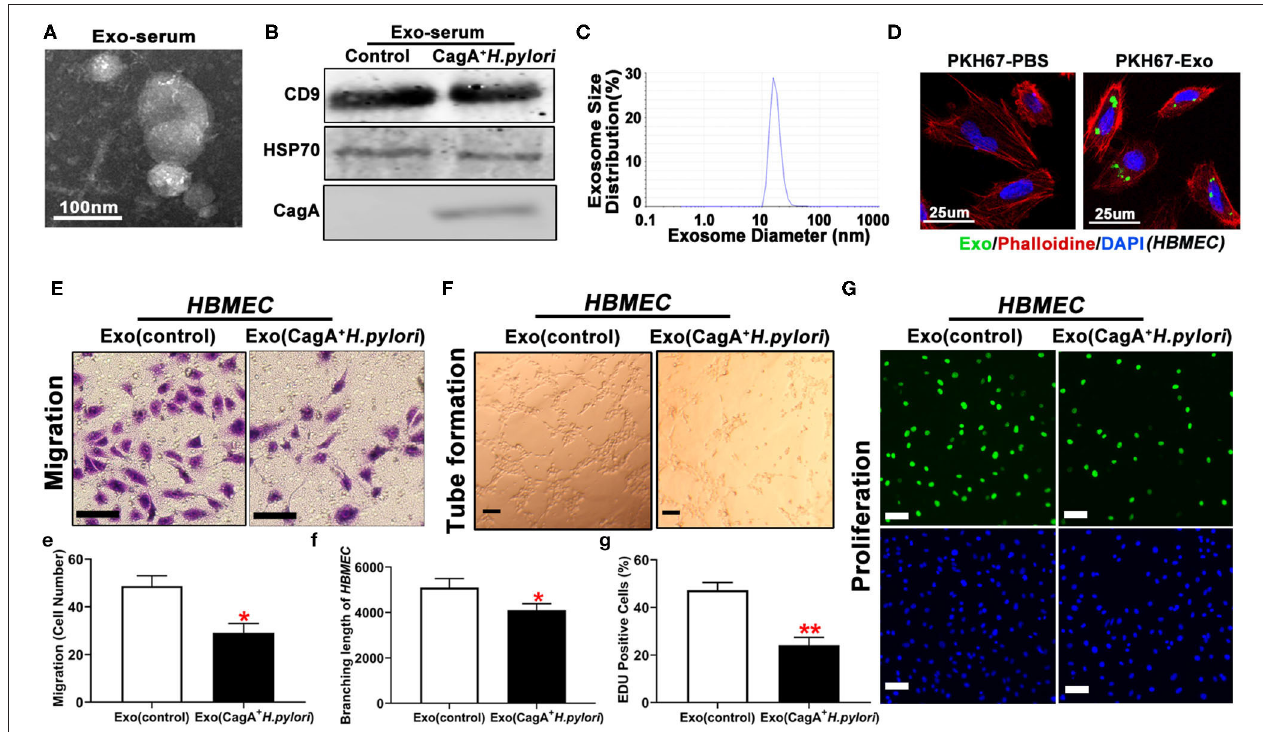
FIGURE 2 | Serum exosomes from patients with CagA + H. pylori infection inhibited endothelial function in vitro. Exosomes isolated from patients with CagA + H. pylori infection exhibited typical exosome morphology (A) , biomarker (CD9 and HSP70) expression (B) , and size distribution (C) . Specific CagA protein presented the serum exosomes (B) . PKH67-labeled exosomes were tested inside the HBMEC using a confocal microscope (D) , indicating that the exosomes carrying CagA protein entered the HBMEC. Exposure to the CagA-containing exosomes significantly inhibited the migration (E,e) , tube formation (F,f) , and proliferation (G,g) of HBMEC as compared with controls (scale bar = 100 µ m). Exo: exosomes. Exo(controls): serum exosomes from healthy subjects. * p < 0.05, ** p < 0.01 by t-test. Data were presented as the mean ± SE. The experiment was repeated three times for every measurement. CagA, cytotoxin-associated gene A; HBMEC, human brain microvascular endothelial